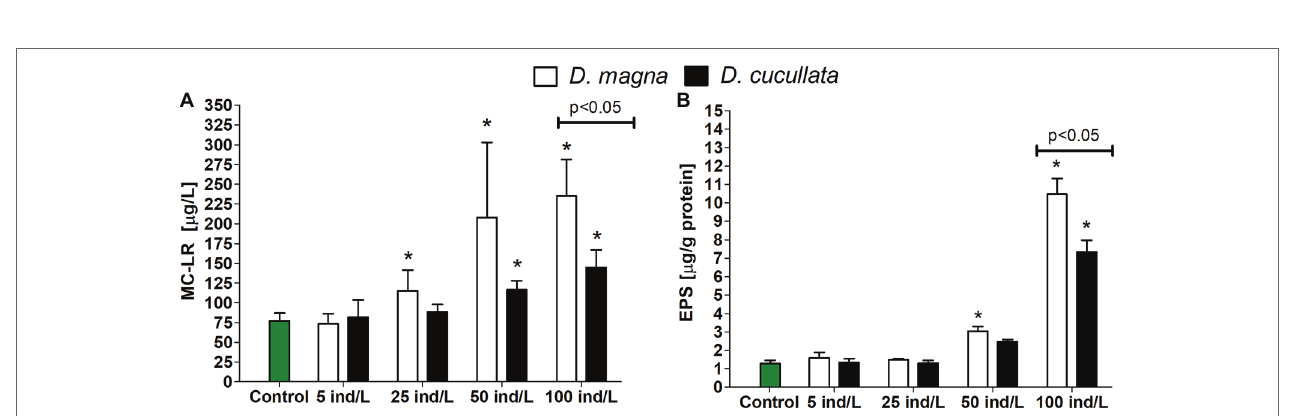
FIGURE 5 | The extracellular concentration (mean and SD) of microcystin-LR (A) and level of bound exopolysaccharide (EPS) fraction (B) in M. aeruginosa exposed for 7 days to different concentrations of D. magna and D. cucullata ( n = 5). An asterisk indicates a significant difference with the control ( p < 0.05; Mann- Whitney U test).